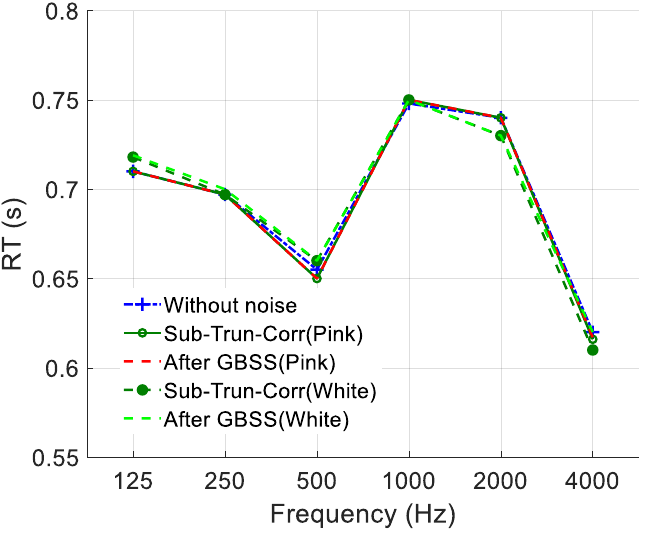
Figure 6. Comparison of the RTs of the filtered RIRs at octave bands with pink noise and white noise with noise levels of − 60